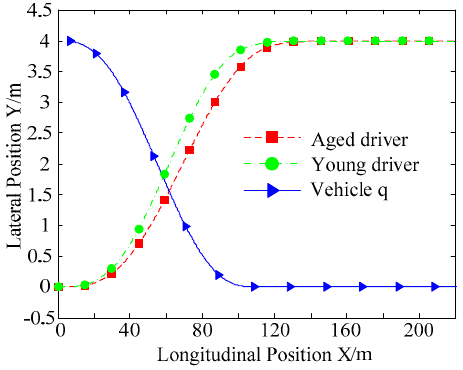
Figure 26. Trajectories of the vehicles driven by different drivers.